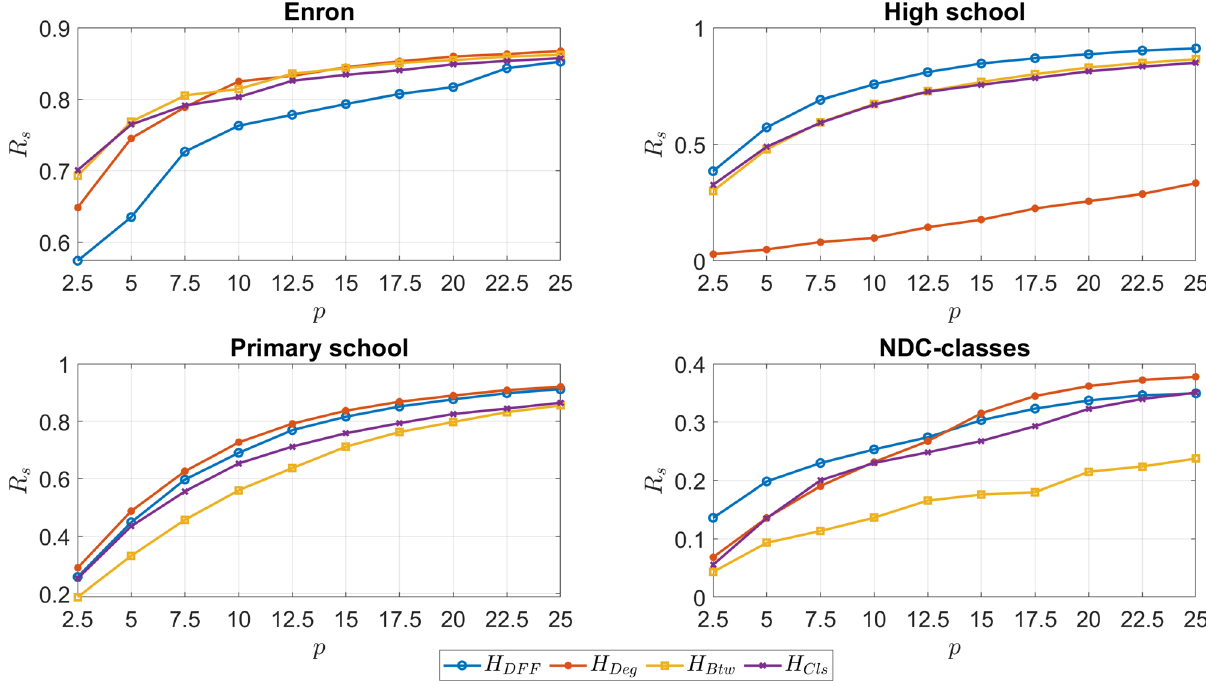
Figure 2. Varying ratio of hyperedges through the implementation of the SIR Model. Here the infection rate is kept constant while the influential hyperedges are obtained by using each of the centrality measures. A higher diffusion index ( R s ) determines the effectiveness of each of these